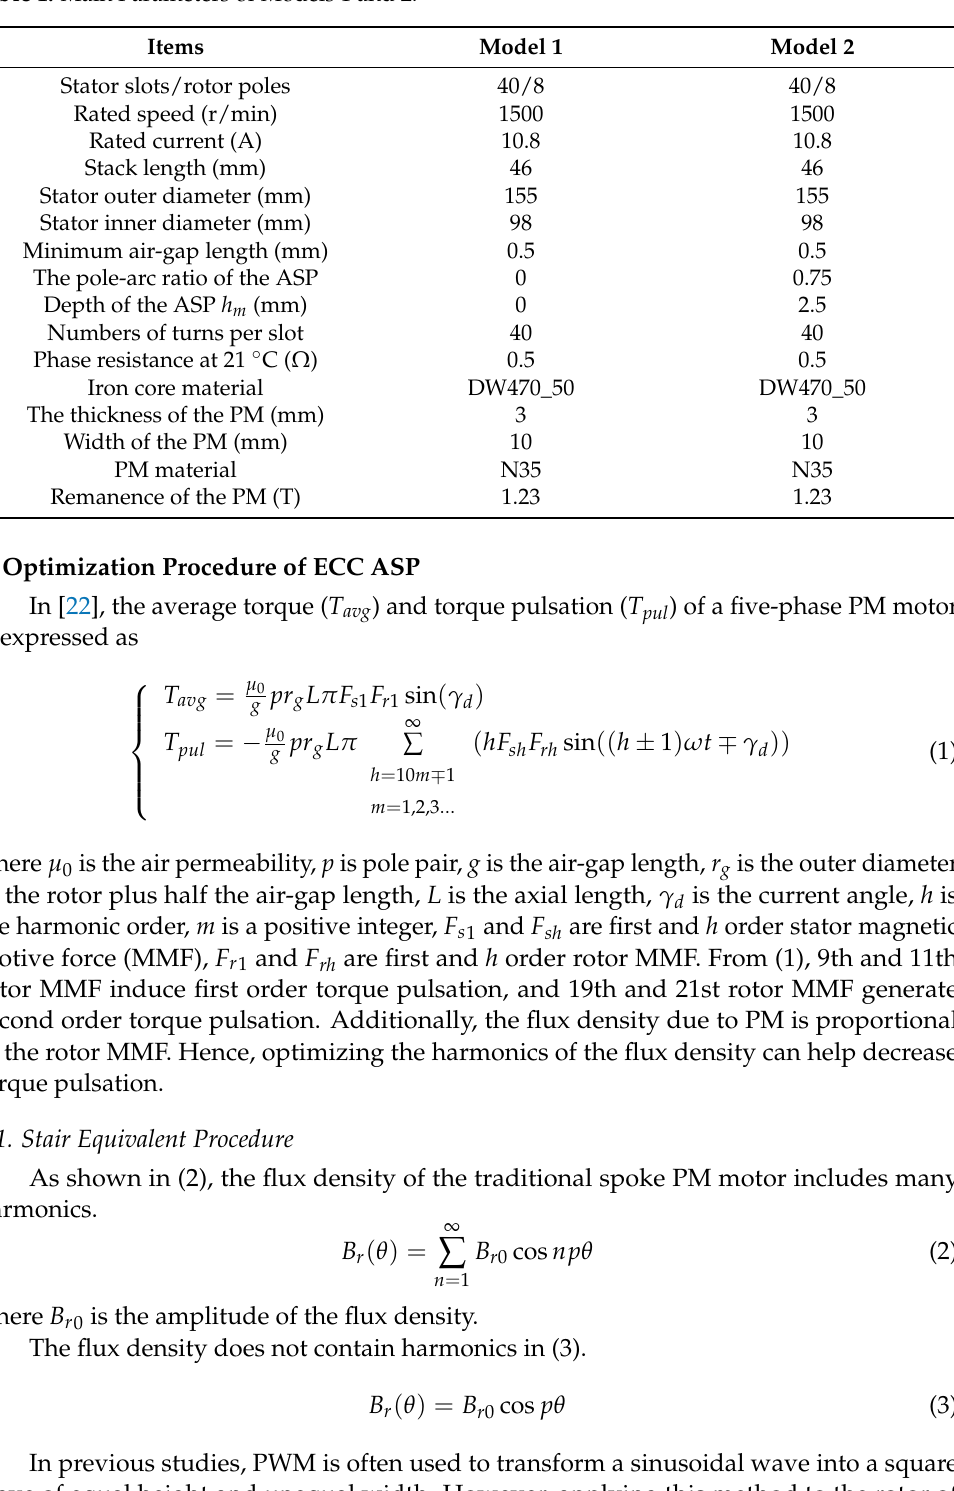
Table 1. Main Parameters of Models 1 and